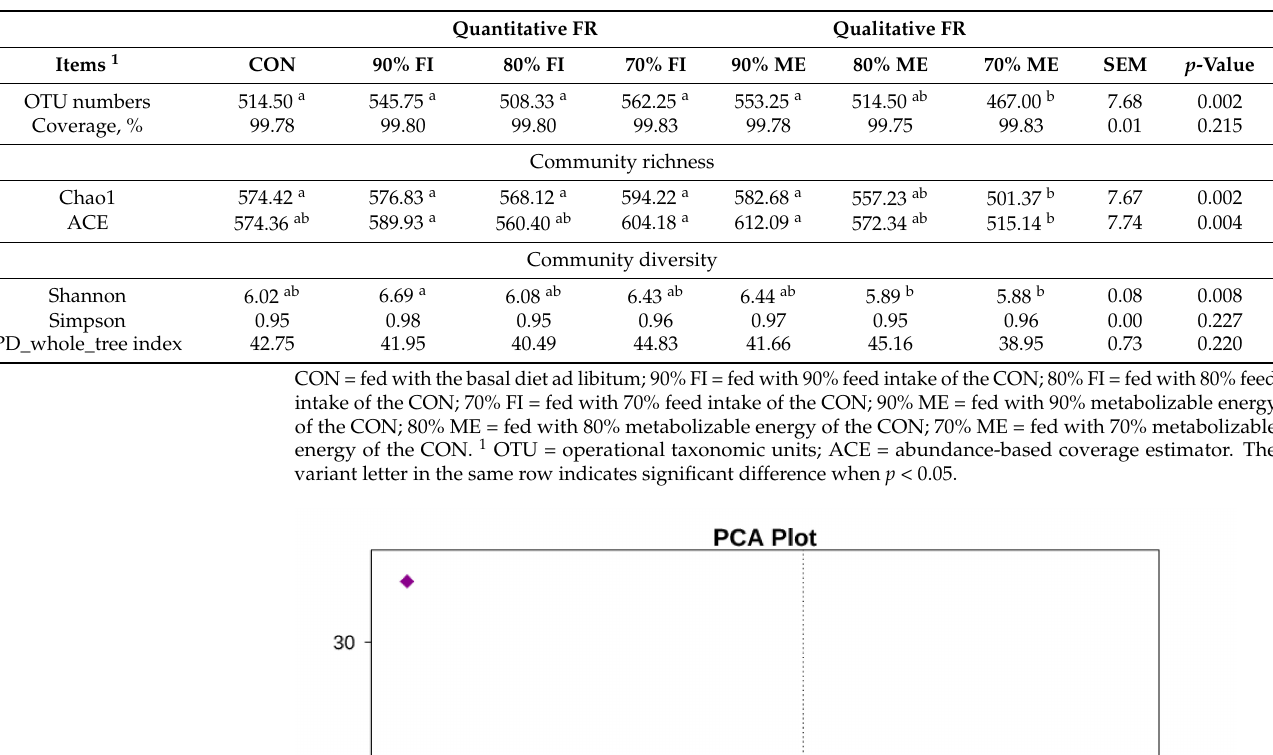
Table 5. Alpha diversity analysis of the microbiota from the cecum of Bearded chickens based on 97% sequence similarity.